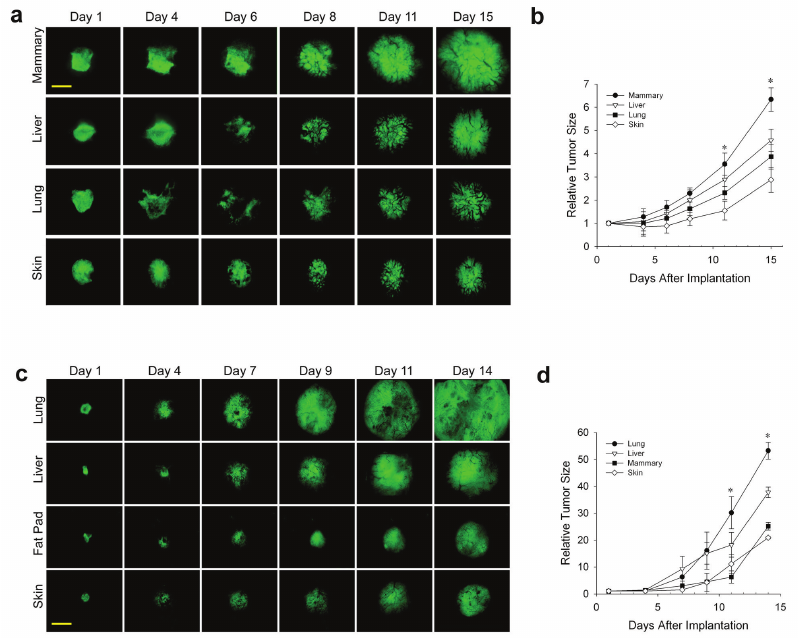
Figure 1. Effect of tissue microenvironment on tumor growth and development. ( a – d ) N202 ( a and b ) and LLC ( c and d ) tumor spheroids expressing H2B-GFP were implanted directly onto the dorsal skin or with mammary, liver or lung tissue as indicated and monitored through the dorsal skin window chamber by IVM at the indicated times. ( b and d ) Relative tumor growth curves. Tumor size on the day indicated was calculated by measuring the total GFP fluorescence signal in each image and dividing this signal by the GFP signal detected one day after implantation (day 1) (see Methods). Scale bar = 500 μm. Mean +/- SD are shown. * = p<0.05. n = 3–4 mice for all